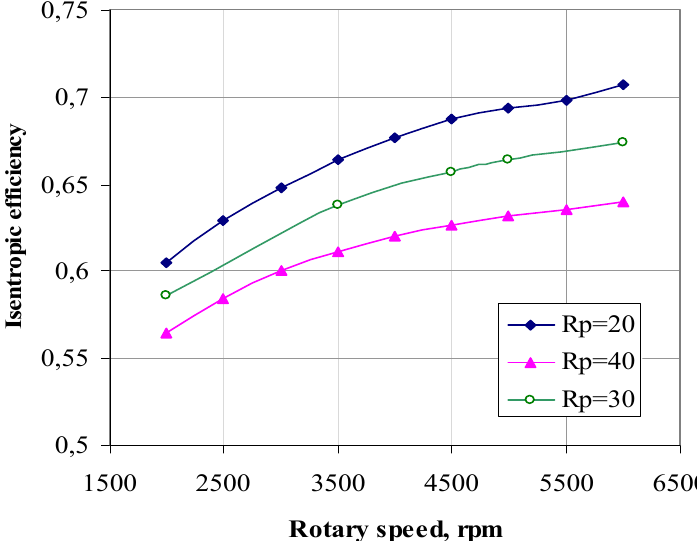
Figure 8. Evolution of the isentropic efficiency at different pressure ratios for rotary speed.